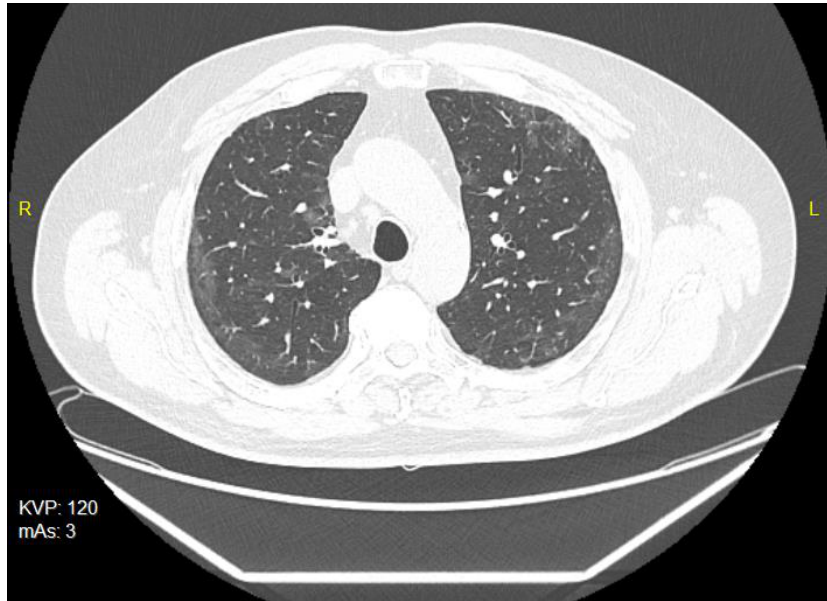
Figure 3. The chest CT scan of 5 February 2021 — bilateral ground-glass opacities. Table 3. Events recorded during the whole study period.